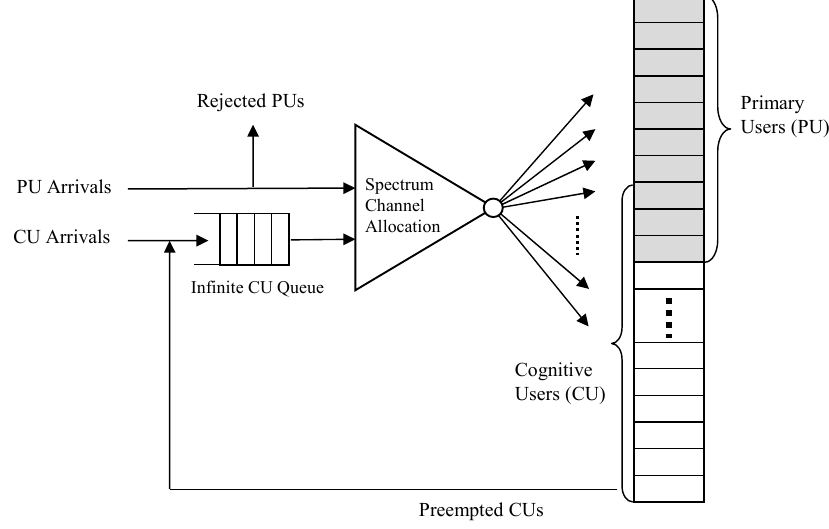
Figure 4. Dynamic spectrum access model for two types of radio systems.